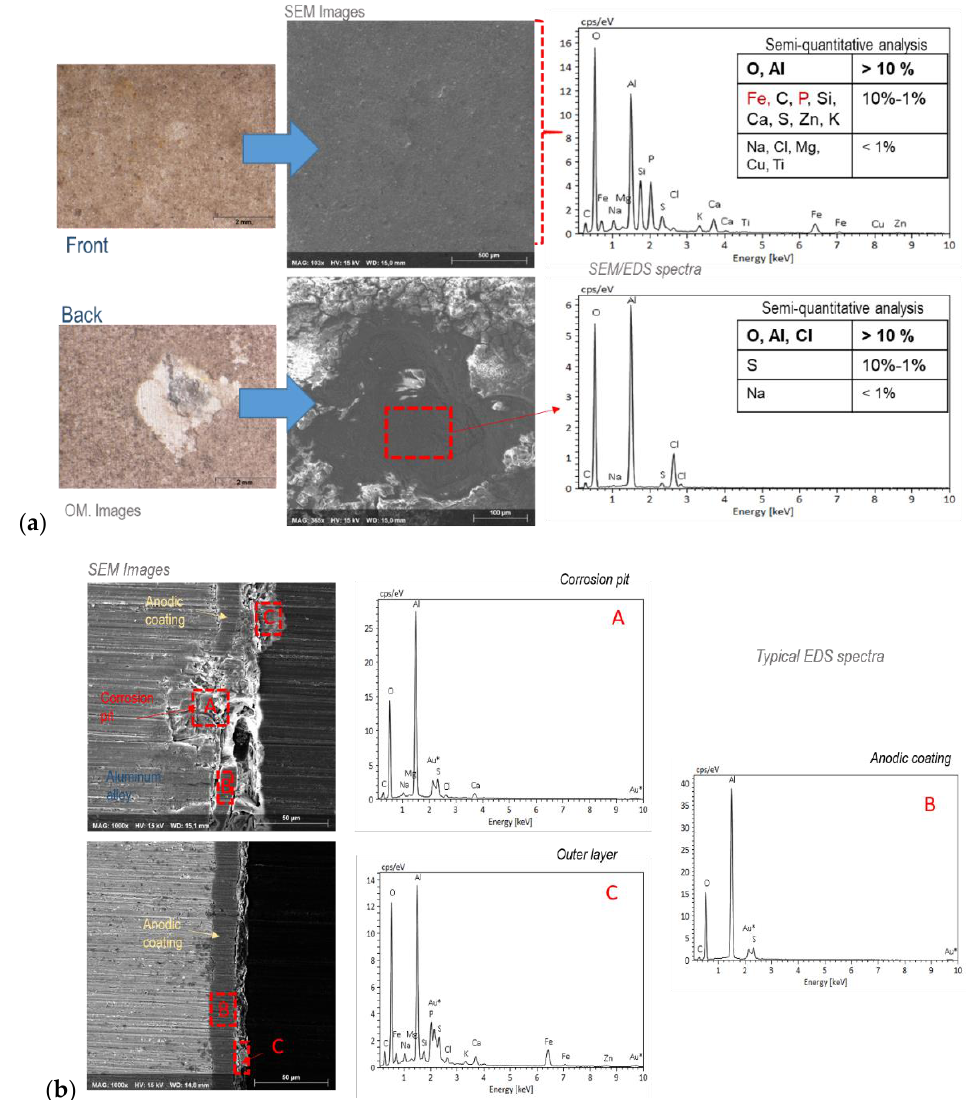
Figure 8. ( a ) Surface and ( b ) cross-sectional morphologies and analyses of the anodized aluminum test specimens exposed at the Barreiro test site after 10 years of exposure. The OM and SEM images were obtained from zones with and without corrosion (pitting) of the aluminum substrate; the EDS spectra and the respective semi-quantitative analysis results shown are relative to the signaled zones in the SEM images.